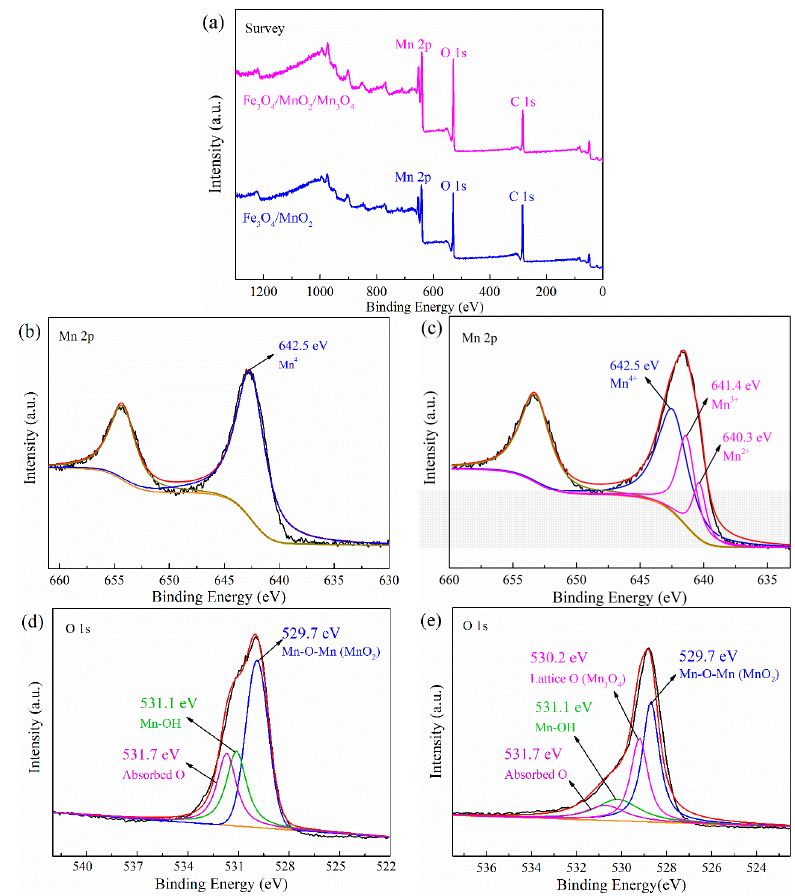
Figure 4. XPS spectrum of hollow flower-like Fe 3 O 4 /MnO 2 microspheres and hollow flower-like Fe 3 O 4 /MnO 2 /Mn 3 O 4 photocatalyst ( a ); Mn 2p spectra of hollow Fe 3 O 4 /MnO 2 spheres ( b ) and hollow flower-like Fe 3 O 4 /MnO 2 /Mn 3 O 4 microspheres ( c ); O 1s spectra of hollow Fe 3 O 4 /MnO 2 microspheres ( d ) and hollow flower-like Fe 3 O 4 /MnO 2 / Mn 3 O 4 microspheres ( e) . flower-like Fe 3 O 4 / MnO 2 / Mn 3 O 4 microspheres ( c ); O 1s spectra of hollow Fe 3 O 4 / MnO 2 microspheres ( d ) and hollow flower-like Fe 3 O 4 / MnO 2 / Mn 3 O 4 microspheres ( e